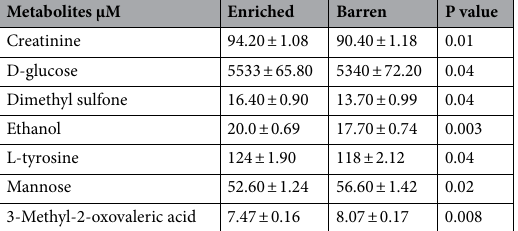
Metabolites µM Enriched Barren P